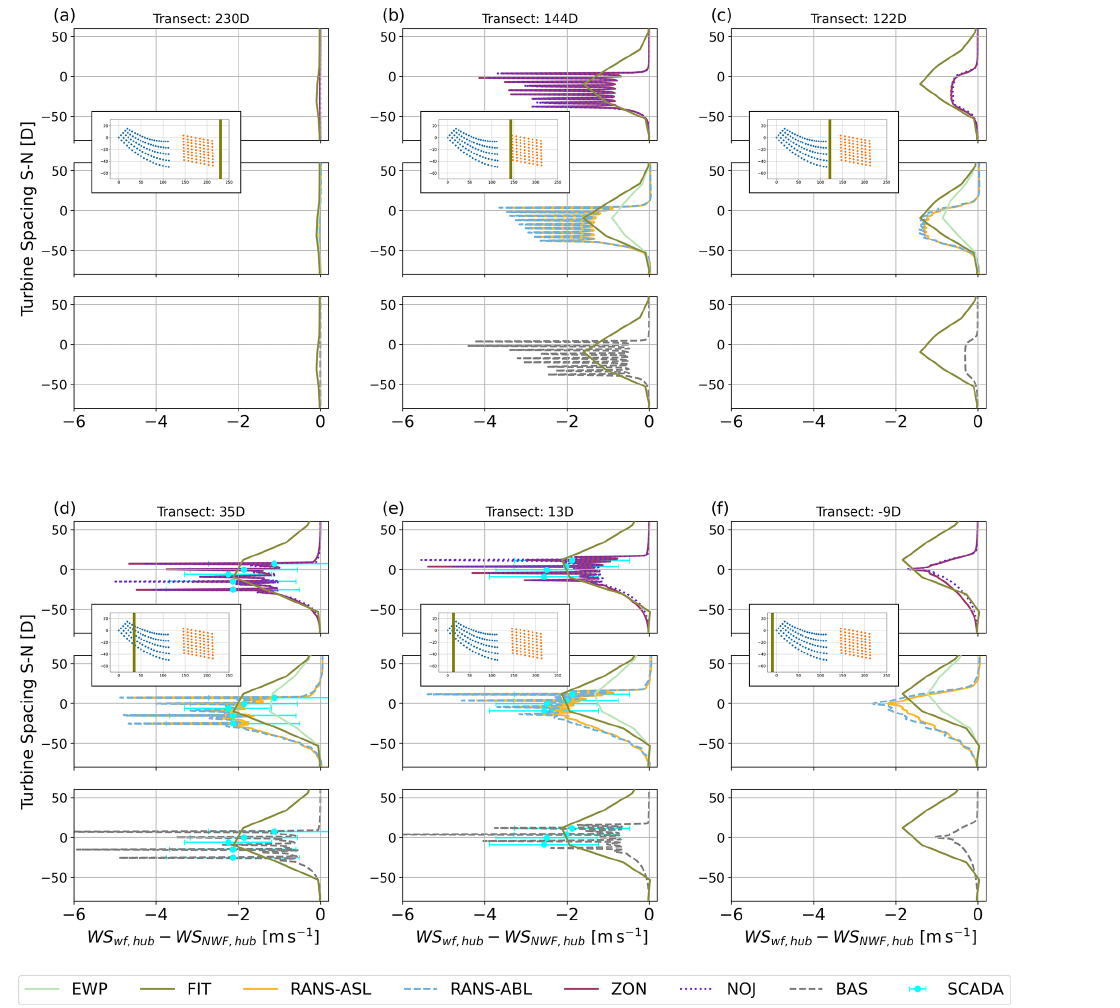
Figure 13. The same as Fig. 12 but for filter method f2.